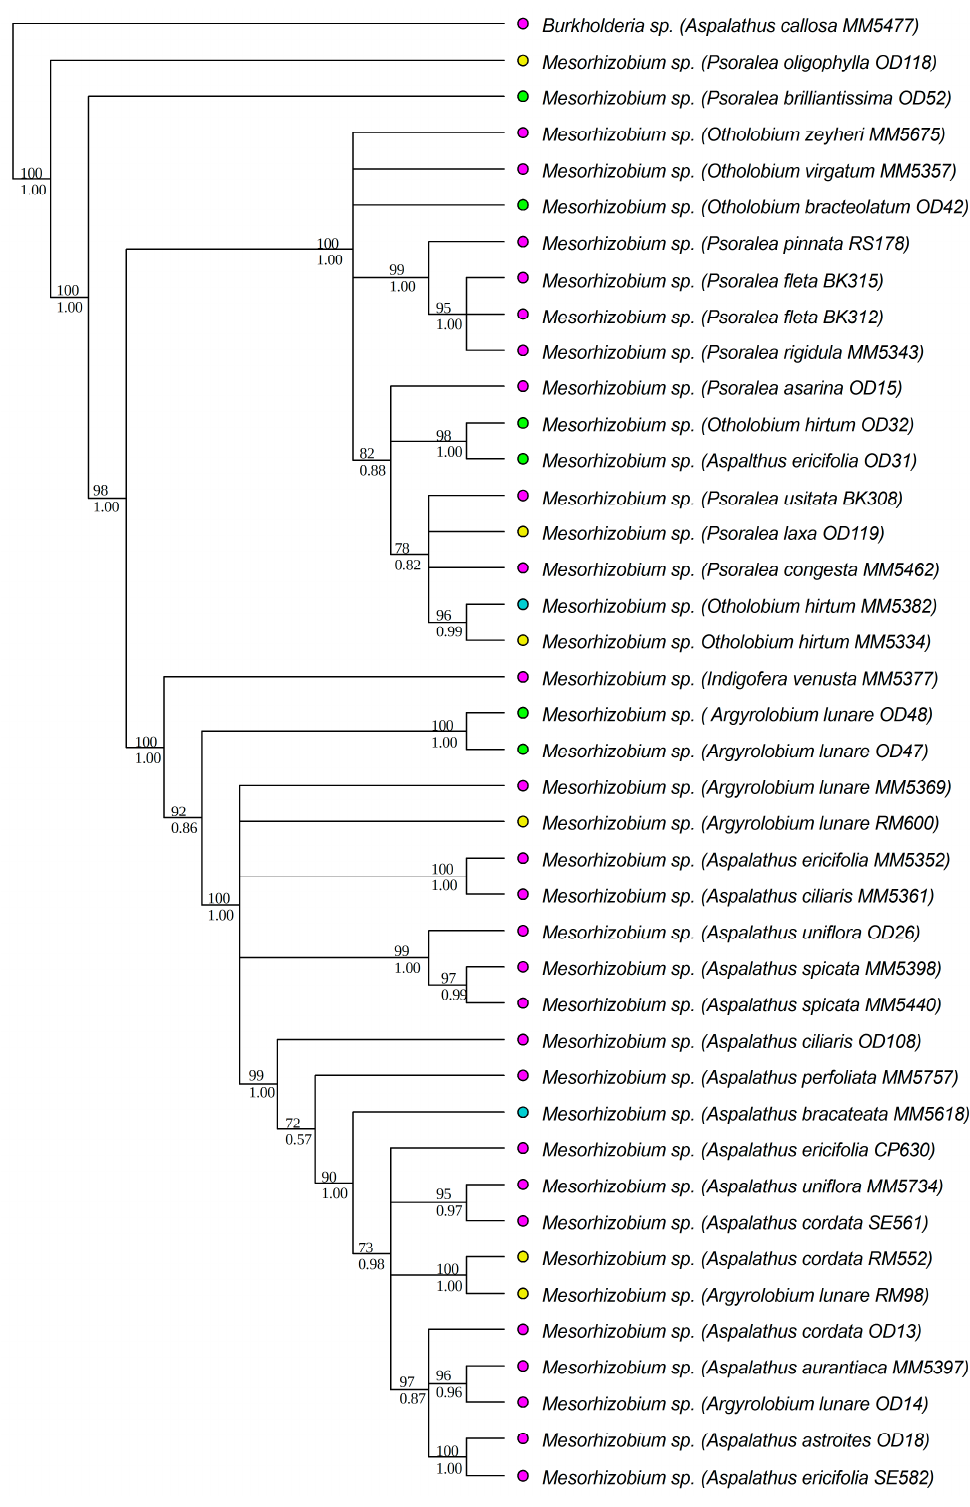
Figure 4. Phylogenetic relationships of Mesorhizobium strains based on nodA data. Names of the legume hosts and rhizobial strain numbers are in parentheses. Strain numbers with the prefixes OD- and MM- are from the study by Lemaire and co-workers [21]. The rest were newly generated in this study. ML bootstrap (%) and BI posterior probabilities are shown above and below nodes, respectively. Colored circles indicate the soil types of the sites where the legumes and their symbionts were collected, blue: granite; green: limestone; pink: sandstone, yellow: shale.